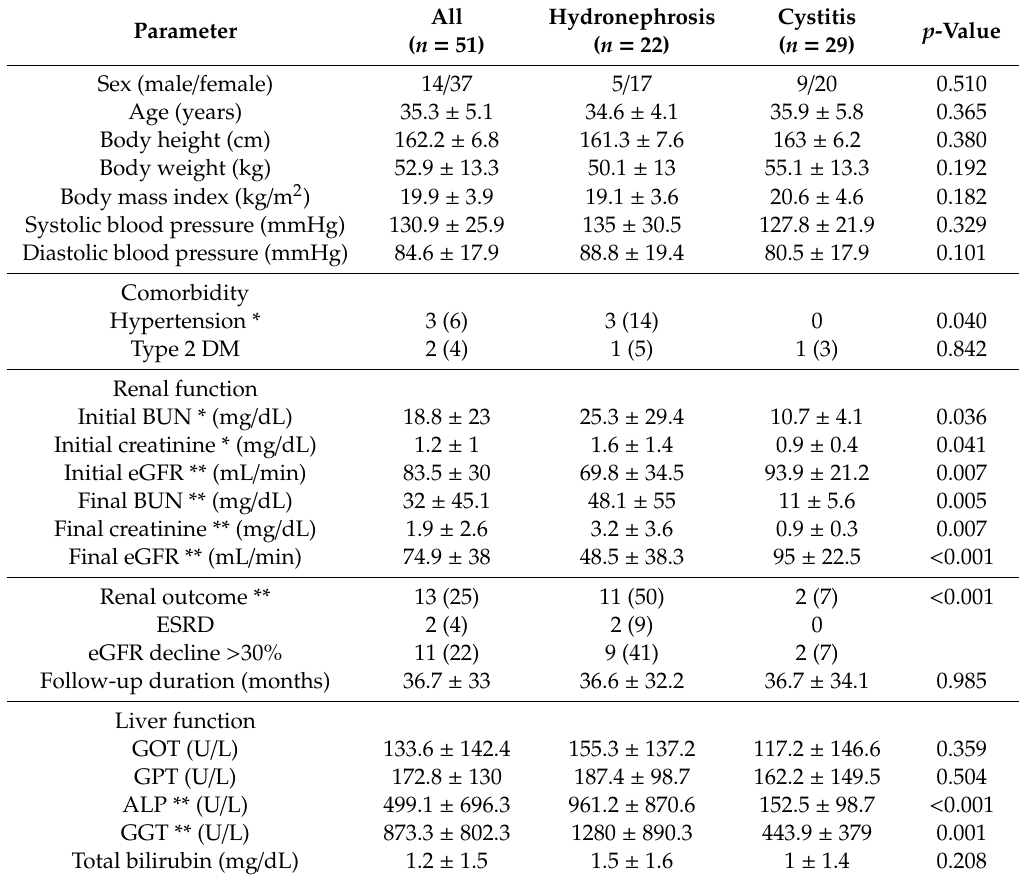
Figure 1. Flow chart of participants in the cohort study. Table 1. Demographic differences between patients with hydronephrosis and cystitis.